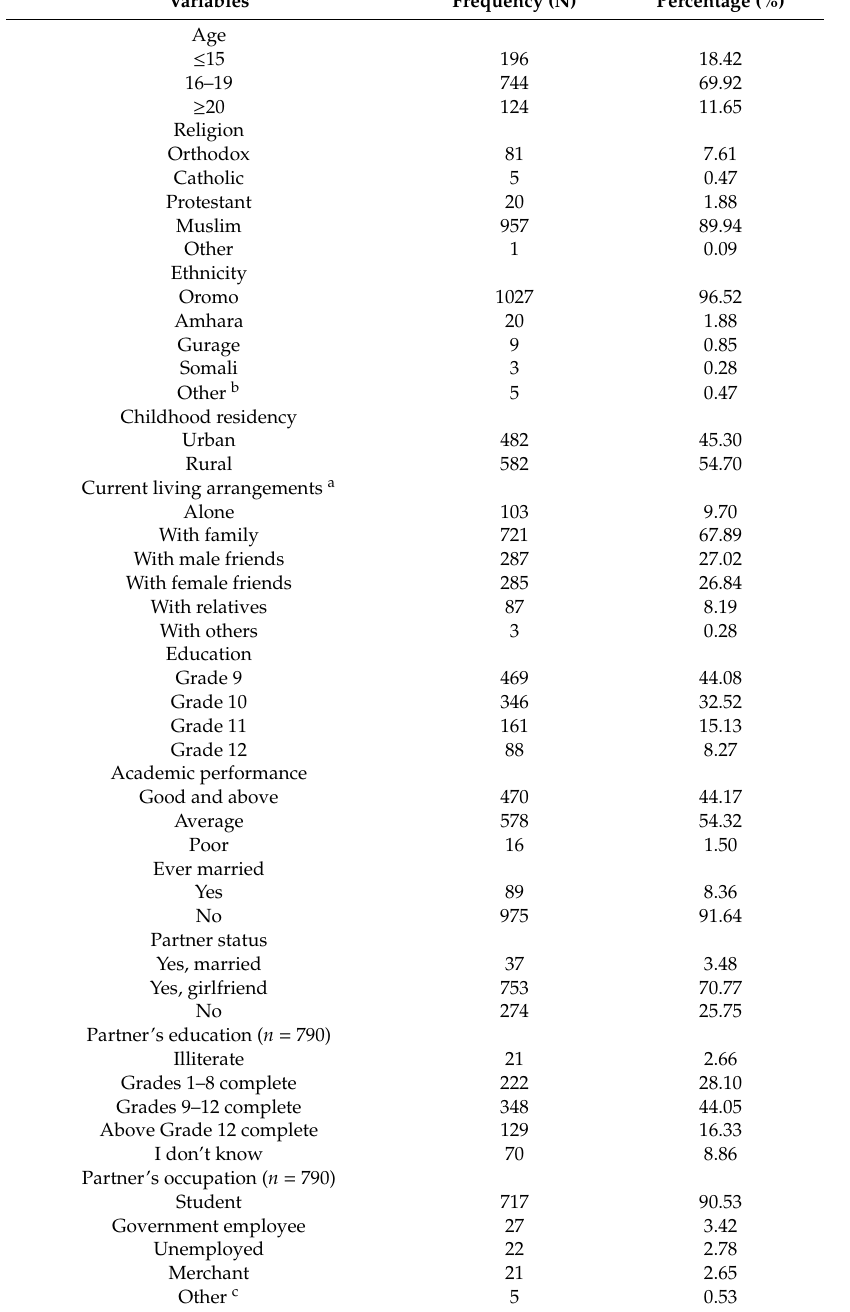
Table 1. Socio-demographic characteristics of the male respondents in East Hararghe, eastern Ethiopia, December